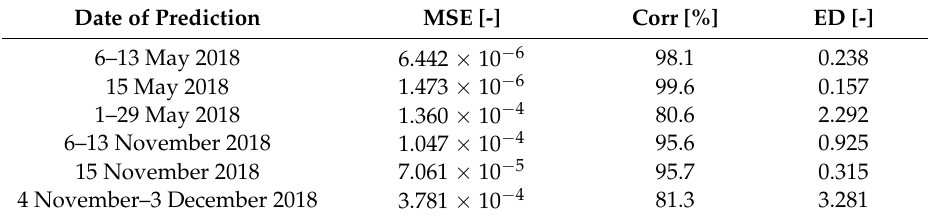
Table 11. The summarization of the evaluation parameters of the wavelet smoothing CO 2 prediction.